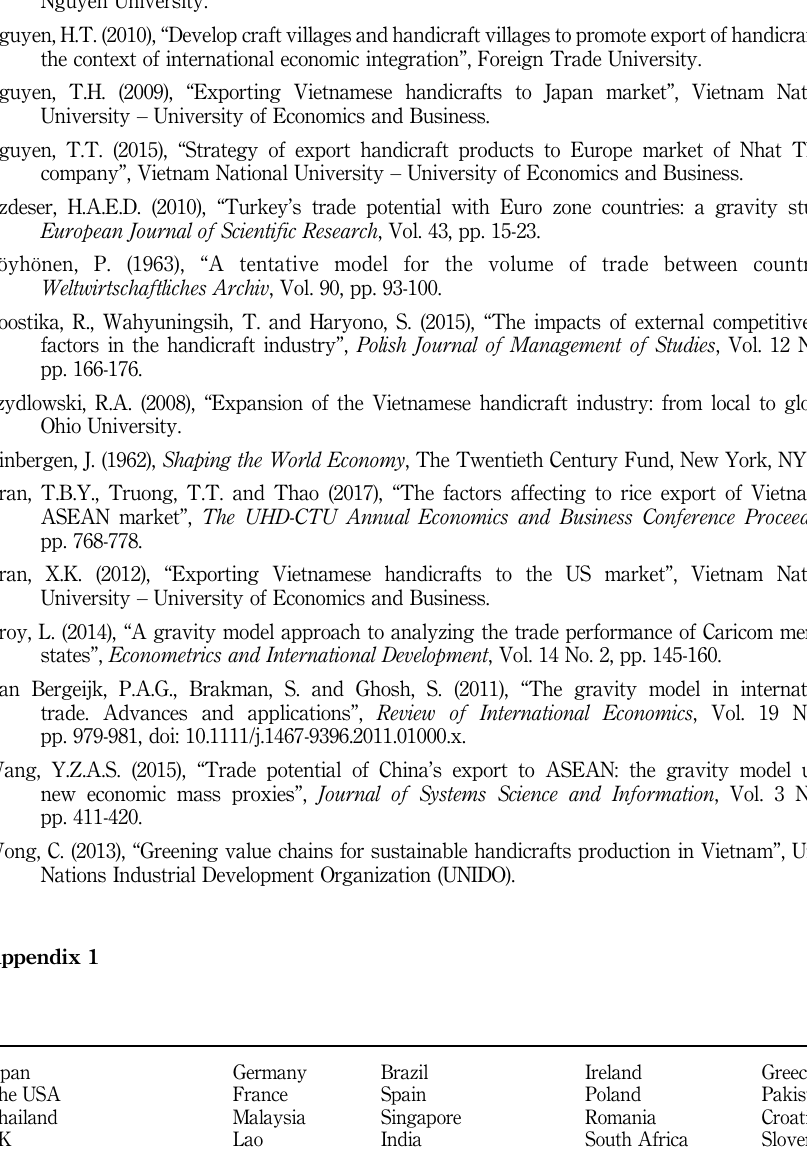
Table AI. List of top 50 trading partners of Vietnam ’ s handicraft